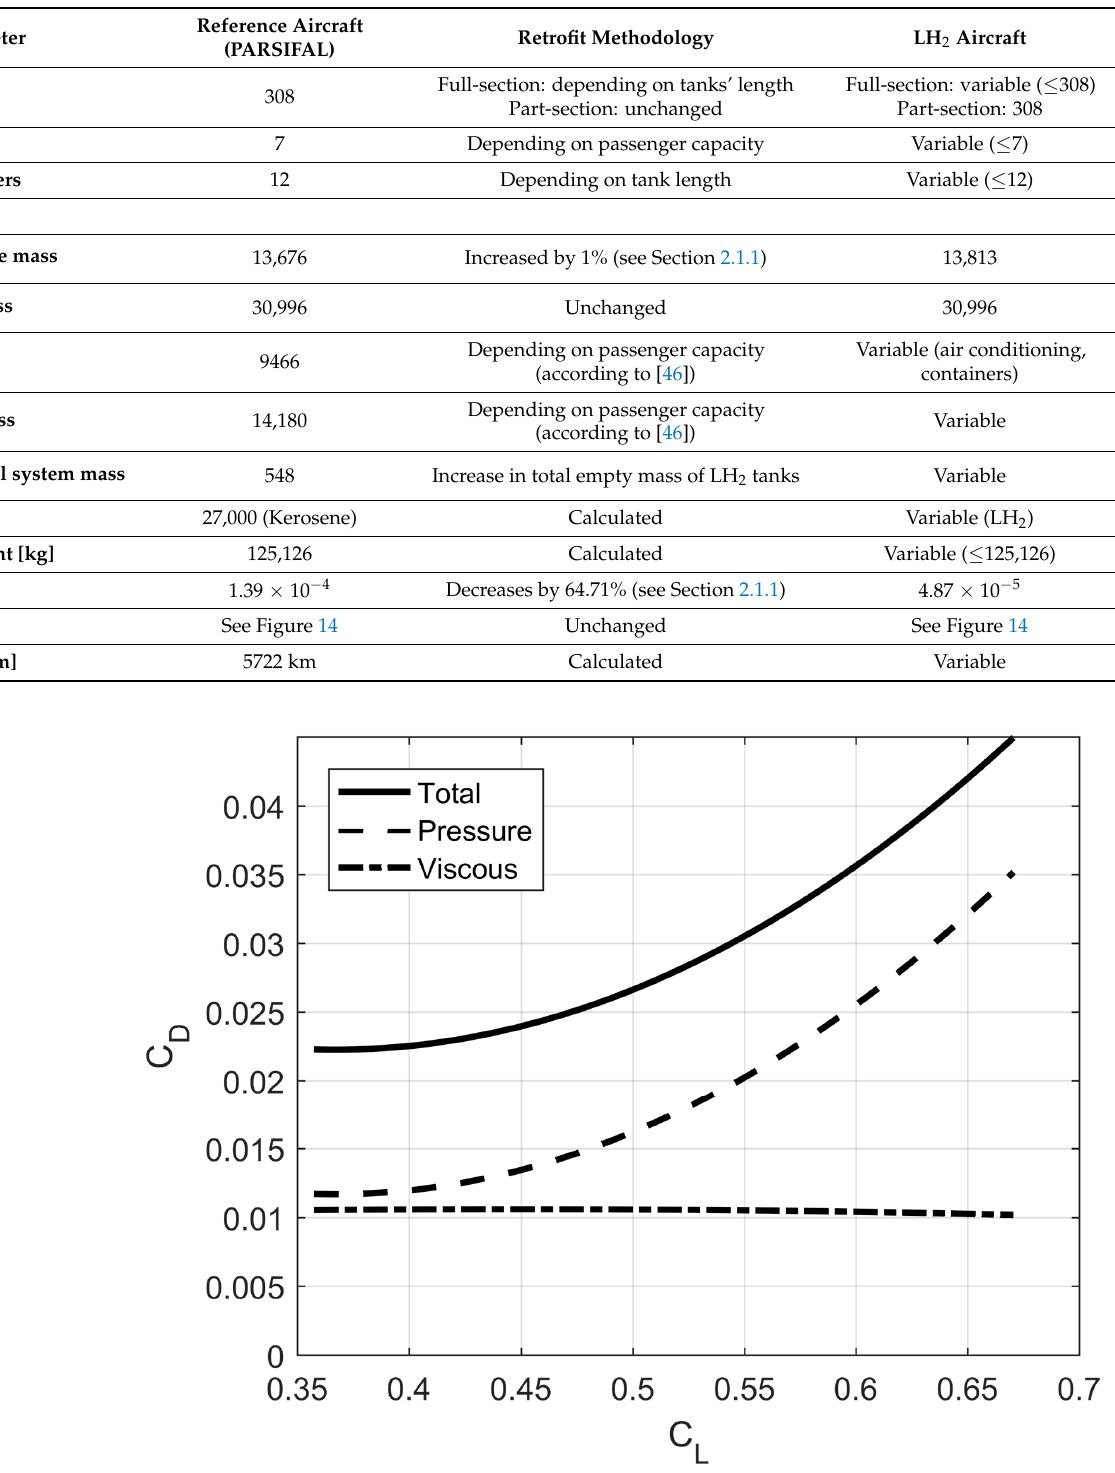
Table 7. Characteristics of the LH 2 aircraft derived by the reference aircraft.